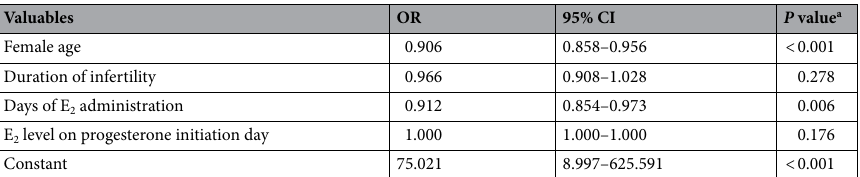
Table 3. Valuables associated with OP/BL analyzed by generalized estimating equation for cleavage-stage embryo transfer. OP/LB ongoing pregnancy/live birth, E 2 estradiol, OR odds ratio, CI confidence interval.